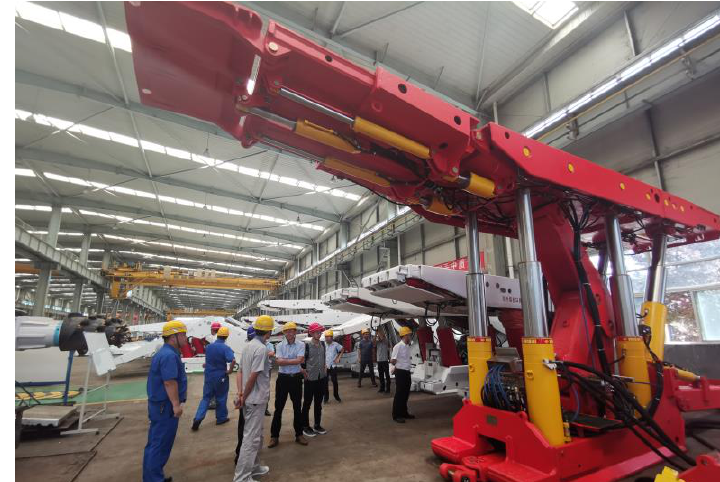
Figure 24. The modified backfilling hydraulic supports.